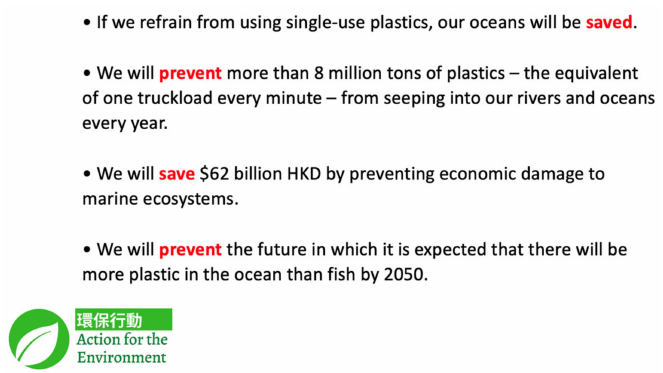
Figure A1. Example of condition 1: gain * text * NGO.